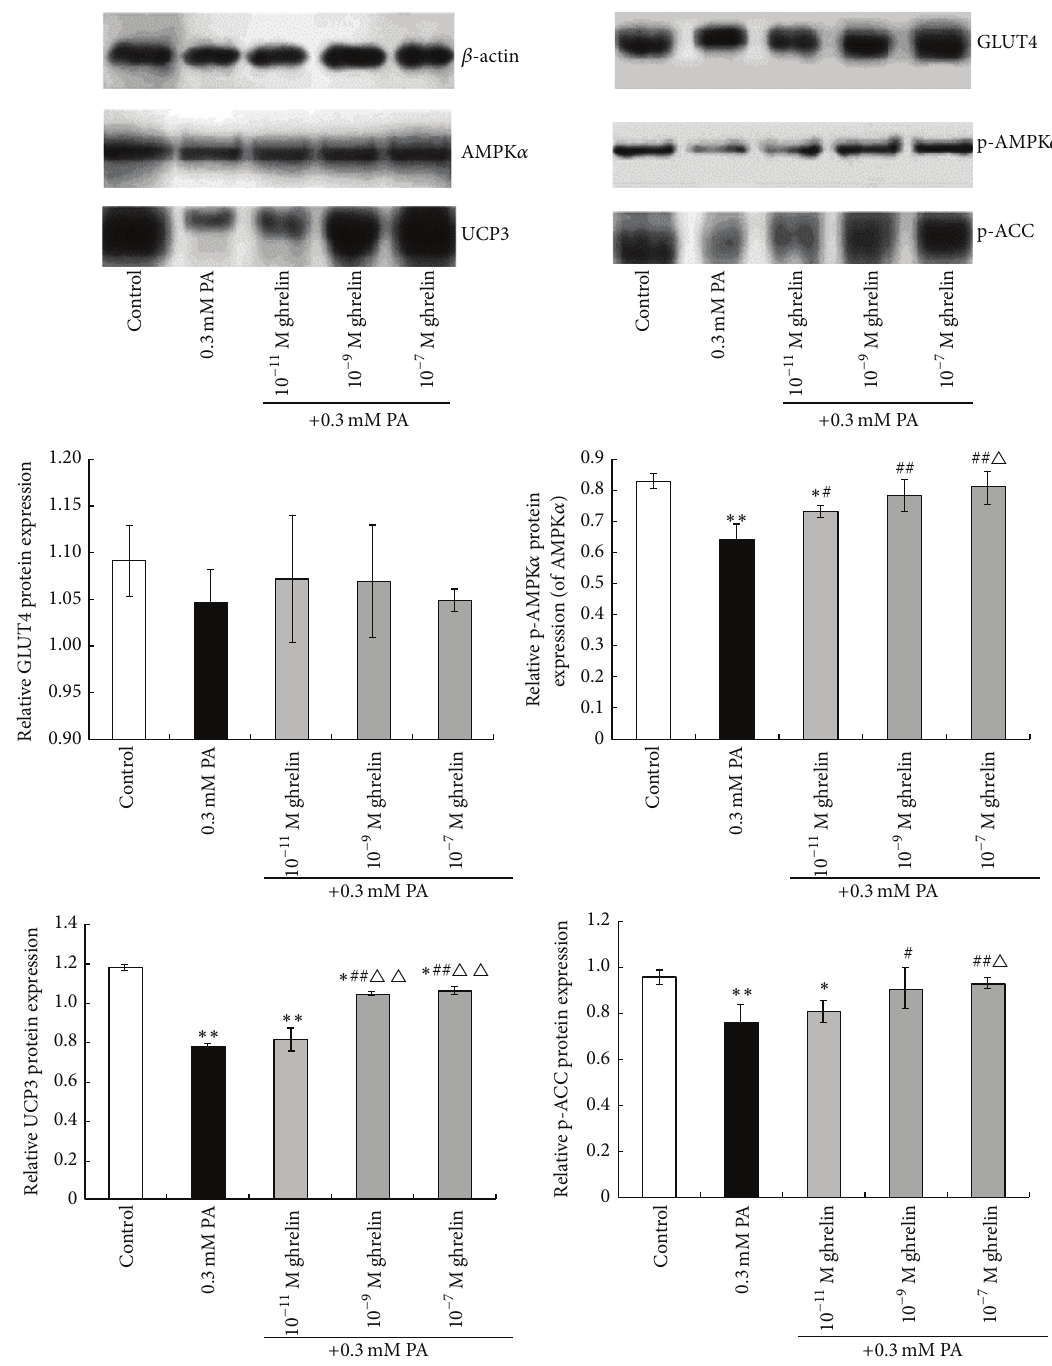
Figure 6: Effects of acylated ghrelin on the protein expression of proteins involved in lipid and glucose metabolism. Protein expression of glucose transporter 4 (GLUT4), AMP-activated protein kinase 𝛼 (AMPK 𝛼 ), phosphorylated AMPK 𝛼 (p-AMPK 𝛼 ), uncoupling protein 3 (UCP3), and phosphorylated acetyl-CoA carboxylase (p-ACC) in primary cultured rat myoblasts under high fat conditions was determined by western blot. 𝛽 -actin was used as internal reference. Data are shown as mean ± SD. ∗ 𝑃 < 0.05 , ∗∗ 𝑃 < 0.01 versus controls; # 𝑃 < 0.05 , ## 𝑃 < 0.01 versus the 0.3 mM PA group; △ 𝑃 < 0.05 , △△ 𝑃 < 0.01 versus the 0.3 mM PA + 10 −11 M acylated ghrelin